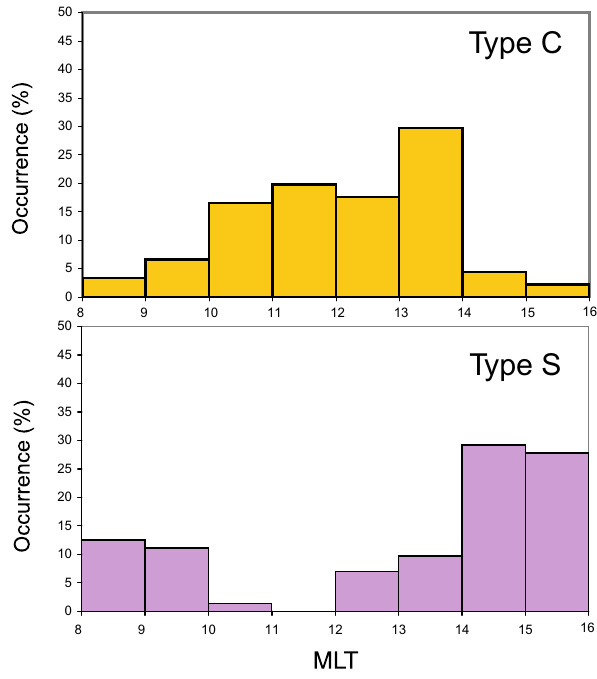
Fig. 11. Occurrence distributions of (a) type C events, and (b) type S